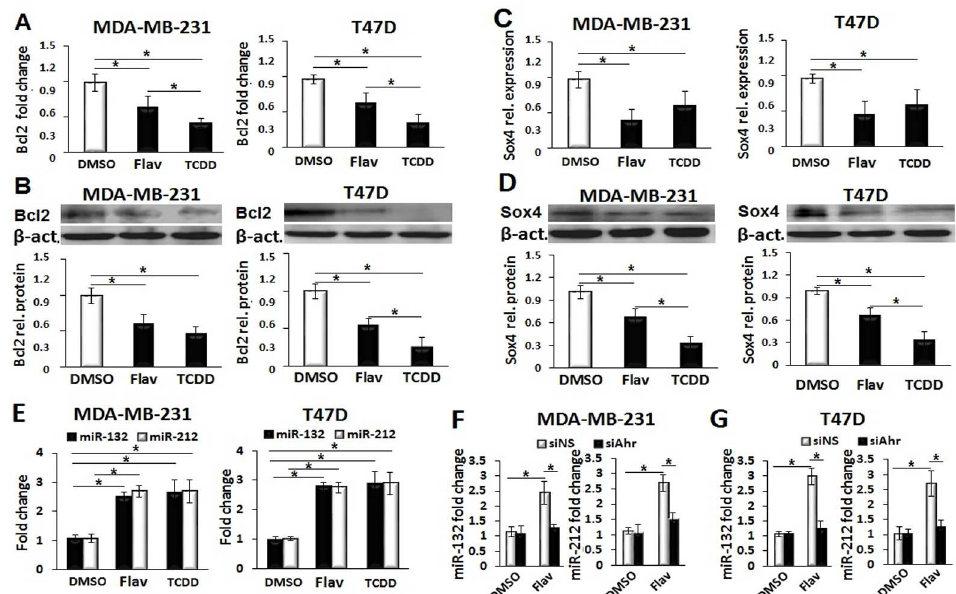
Fig 5. Flavipin suppressesBcl2 and induces Sox4-targeting miR-212/132. Flavipin (200 μ mol/L)or TCDD (10 nmol/L) exerted comparable effects by suppressing mRNA (A) and protein (B) levels of Bcl2 in MDA-MB- 231 and T47D cells in 48 h. Quantification was performed by real-time PCR and western blot. (C, D) Gene expressionof Sox4 was reducedwith Flavipinor TCDD treatment. (E) Flavipinand TCDD inducedmiR-212/ 132 expressionin both cell lines. (F, G) The Flavipin-mediatedexpressionof miR-212/132 was Ahr-dependent. The cells were transfected with siAhr or siNS by electroporation. Data are shown as mean ± SD from representativeexperiment studiedin triplicates. * P <